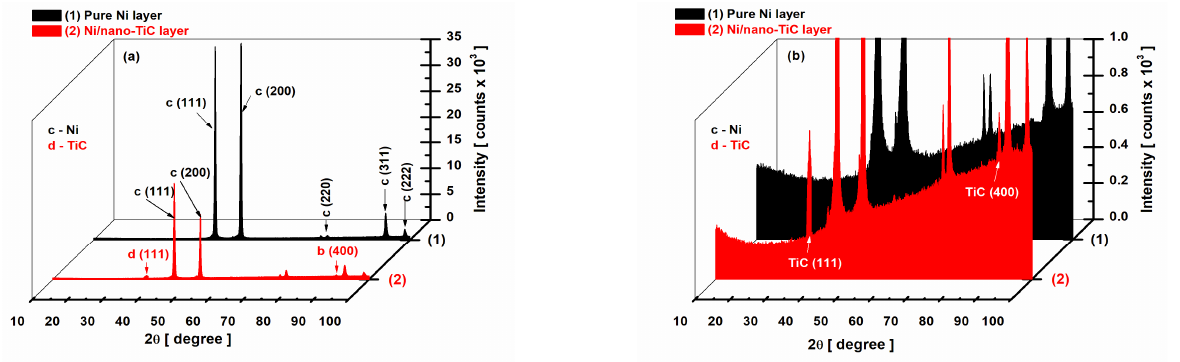
Figure 3. X-ray diffraction patterns for electrodeposited layers: (1) pure Ni layer; (2) Ni/nano-TiC composite layer. ( a ) Full intensity counts; ( b ) magnification of the scale in order to show the inclusion of TiC nanoparticles into the Ni matrix with the specific peaks.